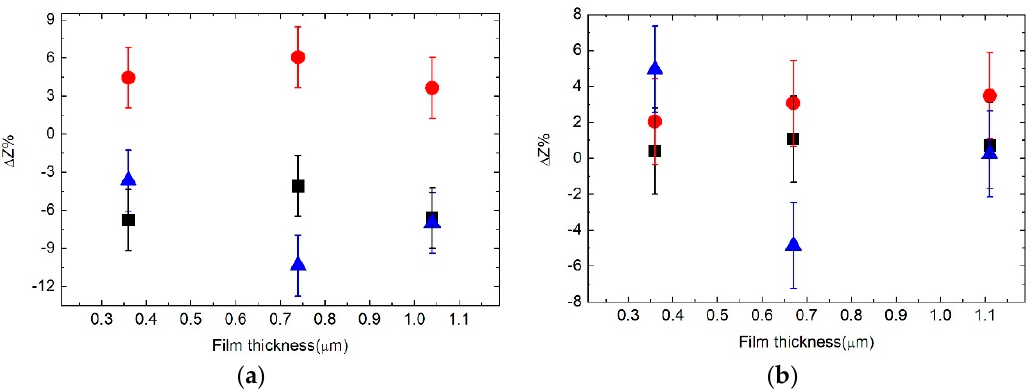
Figure 6. Comparison after the +20 mV stress (black), +100 mV stress (red) and salt spray test (blue) of the calculated Δ Z % value for the gold ( a ) and the palladium ( b ) samples.